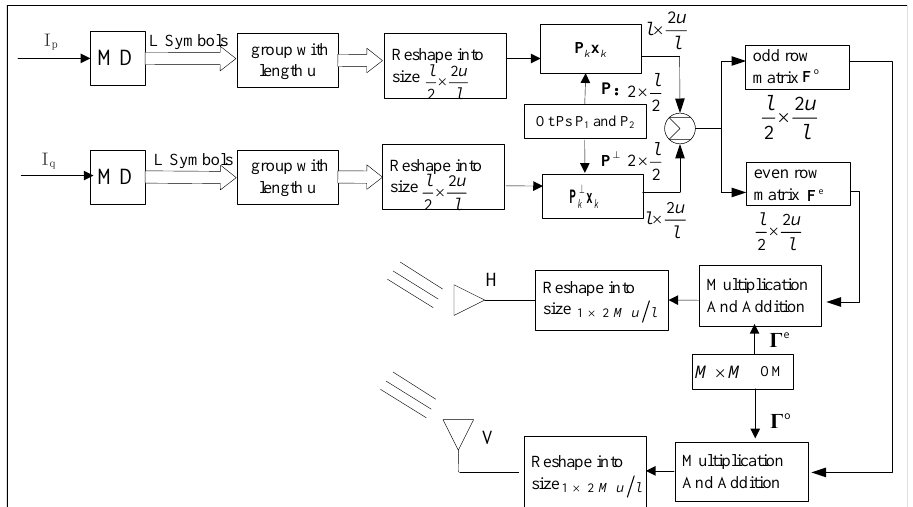
Figure 2. Diagram of the signal processing on the transmitter